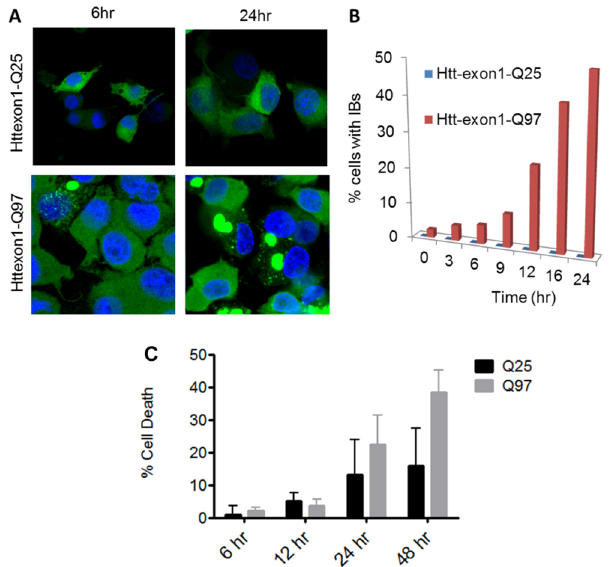
Fig 3. Characteristics of the PC12 model. A. Confocal microscopy of the Q25 and Q97 versions of HTT exon1 after 6 and 24 hrs growth in the presence of 1 μ M ponesterone. Blue = Hoechst dye stained nucleus; green = EGFP. B. Number of cells containing inclusions at different growth times determined by fluorescence microscopy. C. Percent cell death at different growth times as determined by the amount of the intracellular enzyme lactate dehydrogenase released into the medium, an indication of the loss of outer cell membrane